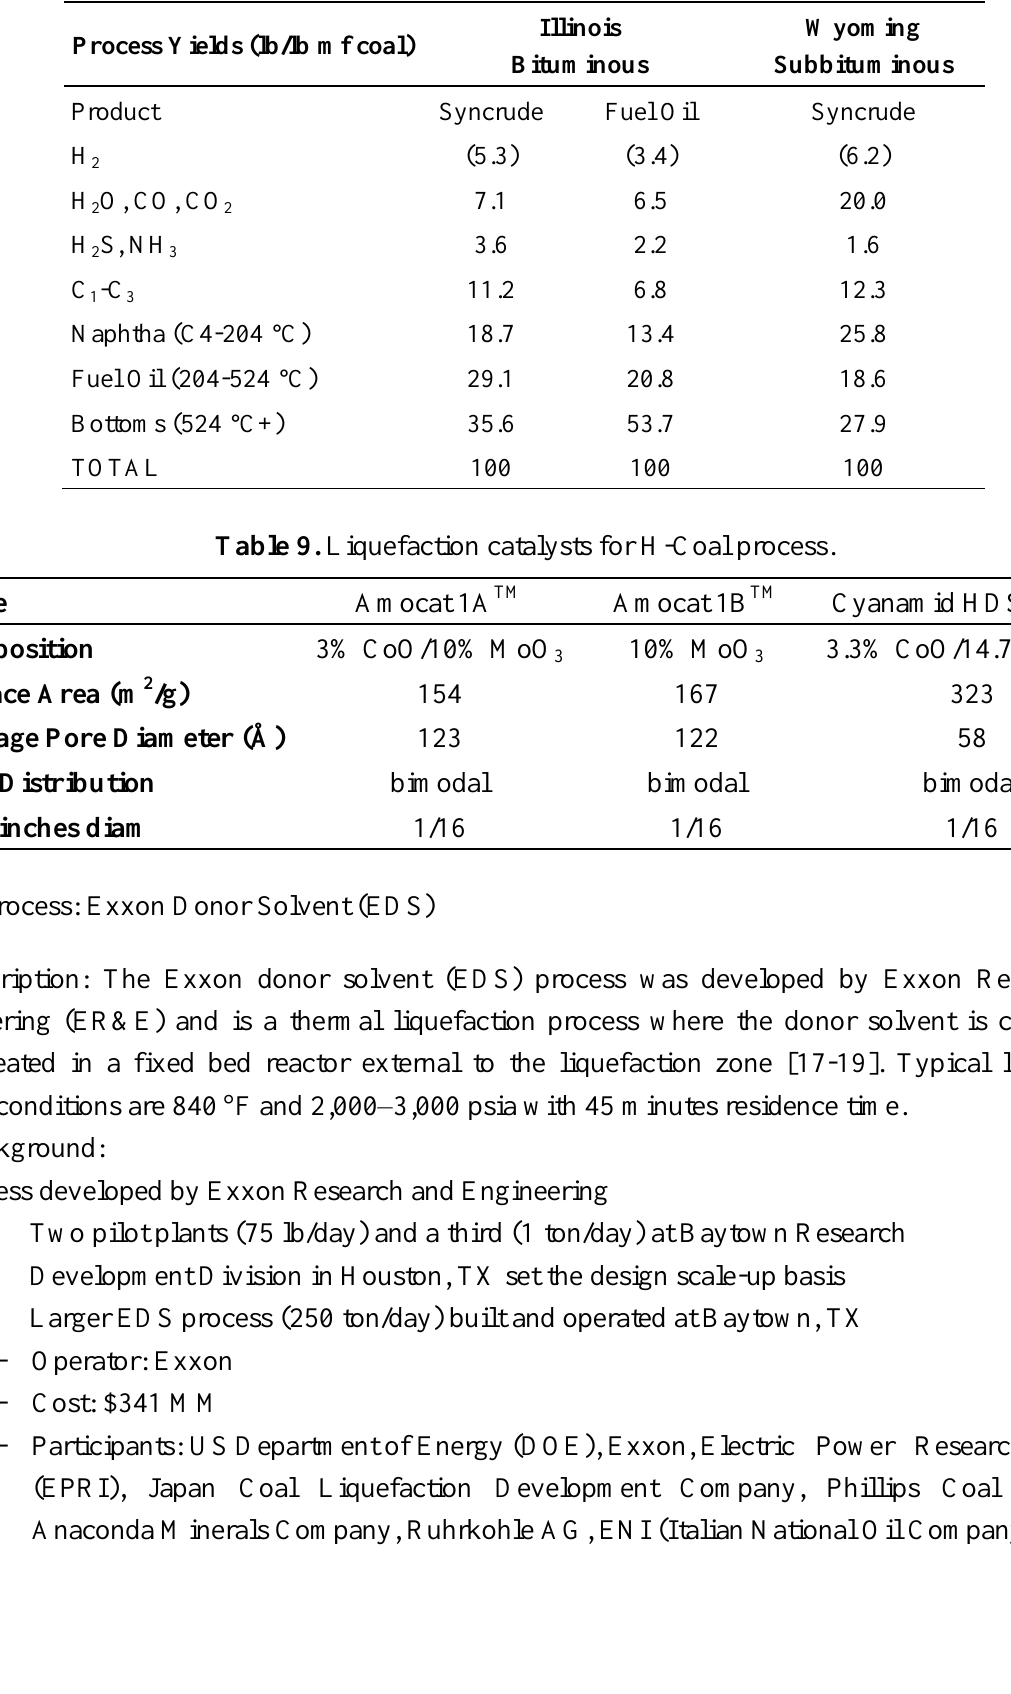
Table 8. Process Yields for H-Coal Process.